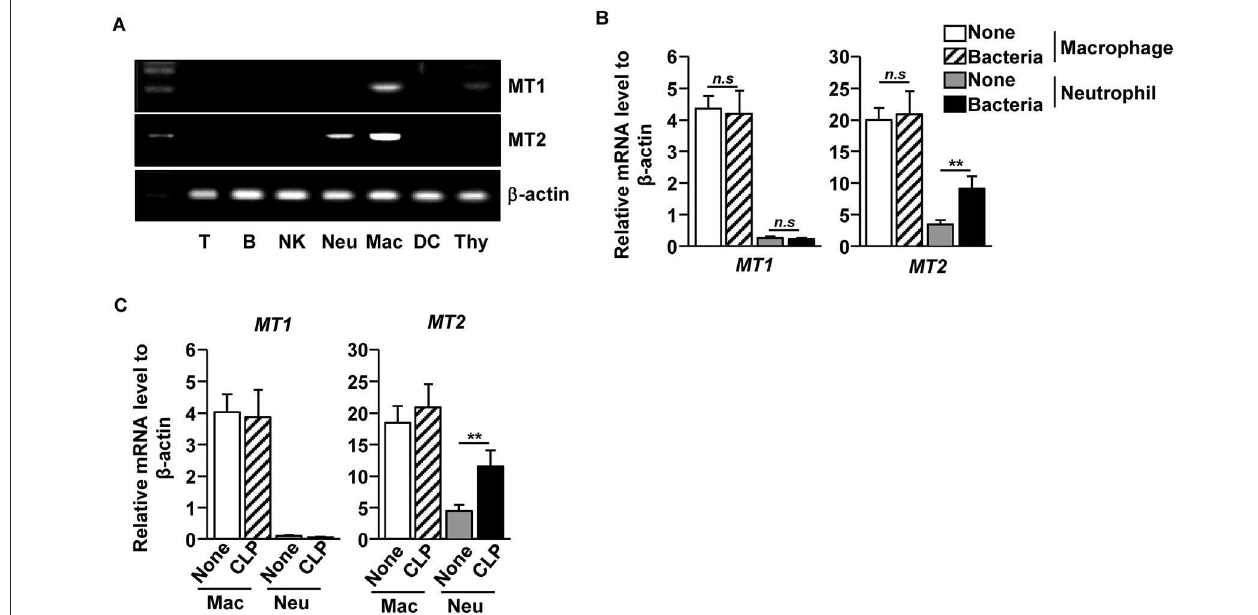
FIGURE 2 | Elevation of melatonin receptor 2 (MT2) level in neutrophils upon bacterial infection. (A) T cells (T), B cells (B) , Consistent with the flow cytometry NK cells (NK), macrophages (Mac), and dendritic cells (DC) were isolated from the spleen, and the neutrophils (Neu) were purified from the bone marrow. The mRNA expression levels of melatonin receptors 1 and 2 (MT1 and MT2) were then measured in the isolated cells. Thymus (Thy) was used as a control. (B) Isolated macrophages and neutrophils were co-cultured with mixture of S. aureus and E. coli for 1h, and the mRNA levels of MT1 and MT2 were measured using real-time qPCR. n = 6 per group, ** p < 0.01. (C) MT1 and MT2 mRNA levels were measured in isolated macrophages and neutrophils 12h after the CLP surgery in mice. Data are the average of six independent samples for each group. ** p <